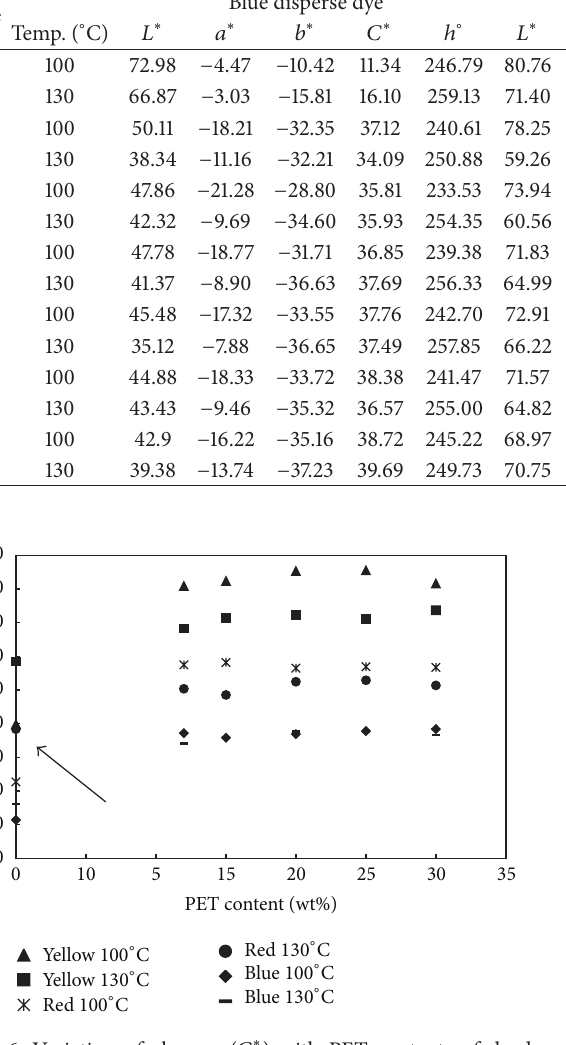
Figure 6: Variation of chroma ( 𝐶 ∗ ) with PET contents of dyed PP/PET blend